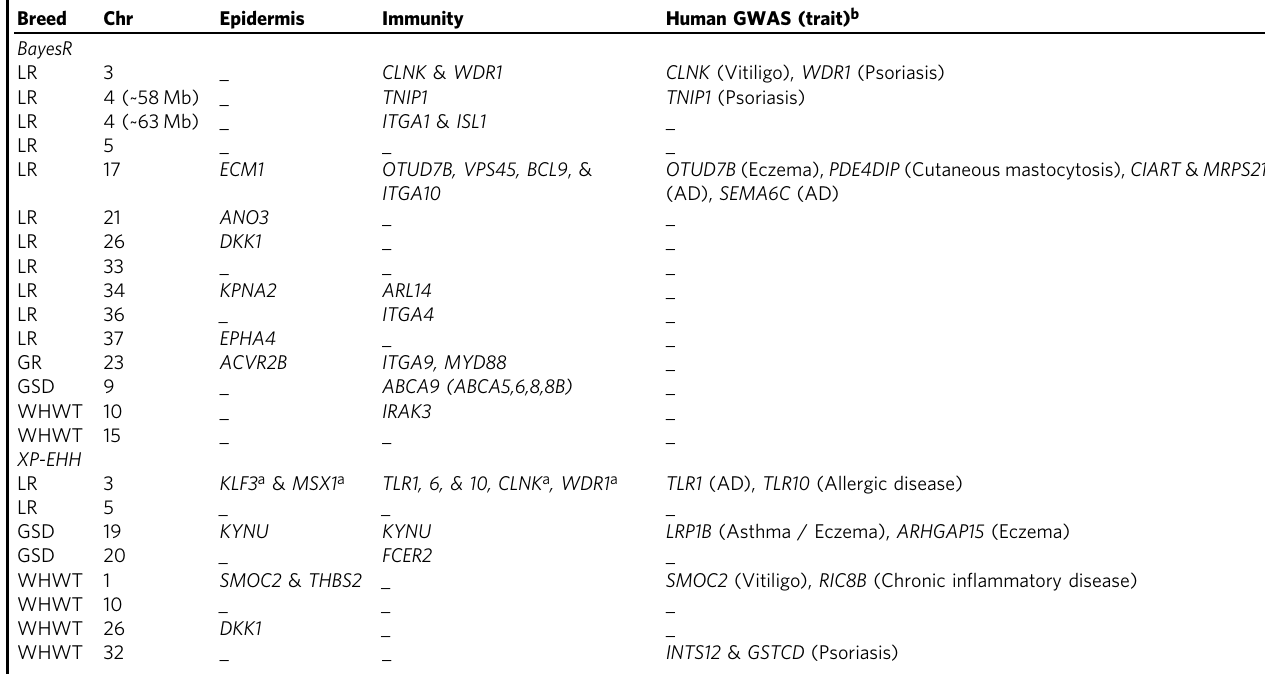
MyD88-dependent TLR signaling pathway, de fi ned with STRING, along with genes from three BayesR regions. This pathway includes activation of the NF- κ B pathway, resulting in downstream activation of in fl ammatory cytokines. Breed type speci fi c selection in GSD was also evident in our data. The selection signal on chromosome 19 was detected in GSD controls of working type and extends across the gene LRP1B , which encodes a 4599 amino acid-long member of the low-density lipoprotein receptor (LDLR) protein family. LRP1B is